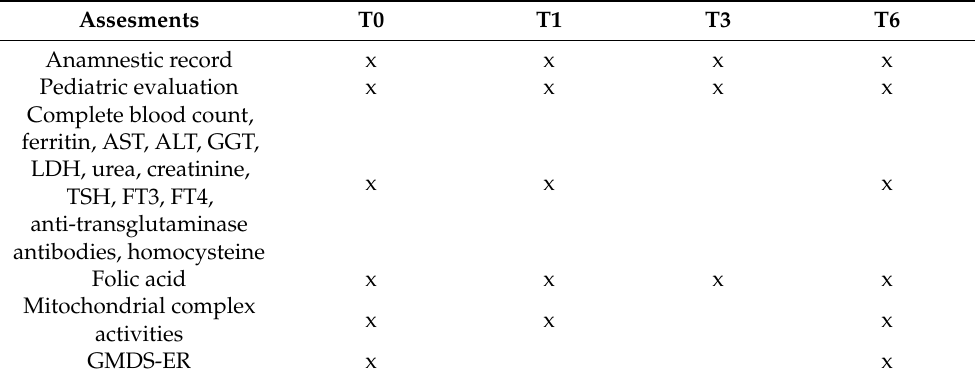
Table 1. Study flow-chart for Down syndrome (DS) subjects treated with epigallocatechin-3-gallate (EGCG) for 6 months (Group